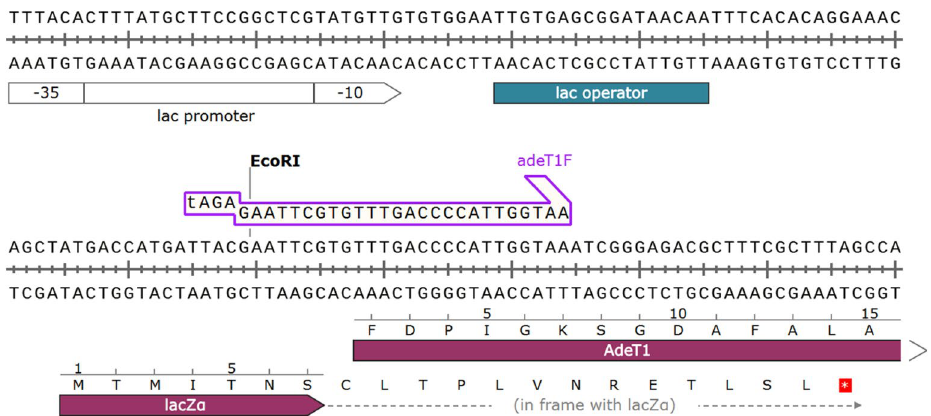
Figure 1. Extract of the plasmid map for the construct pAdeT1 employed by Srinivasan et al. 35 . In this construct, the adeT1 gene is not in frame with a start codon or the open reading frame of lacZα. It is unlikely that this construct can lead to production of AdeT1